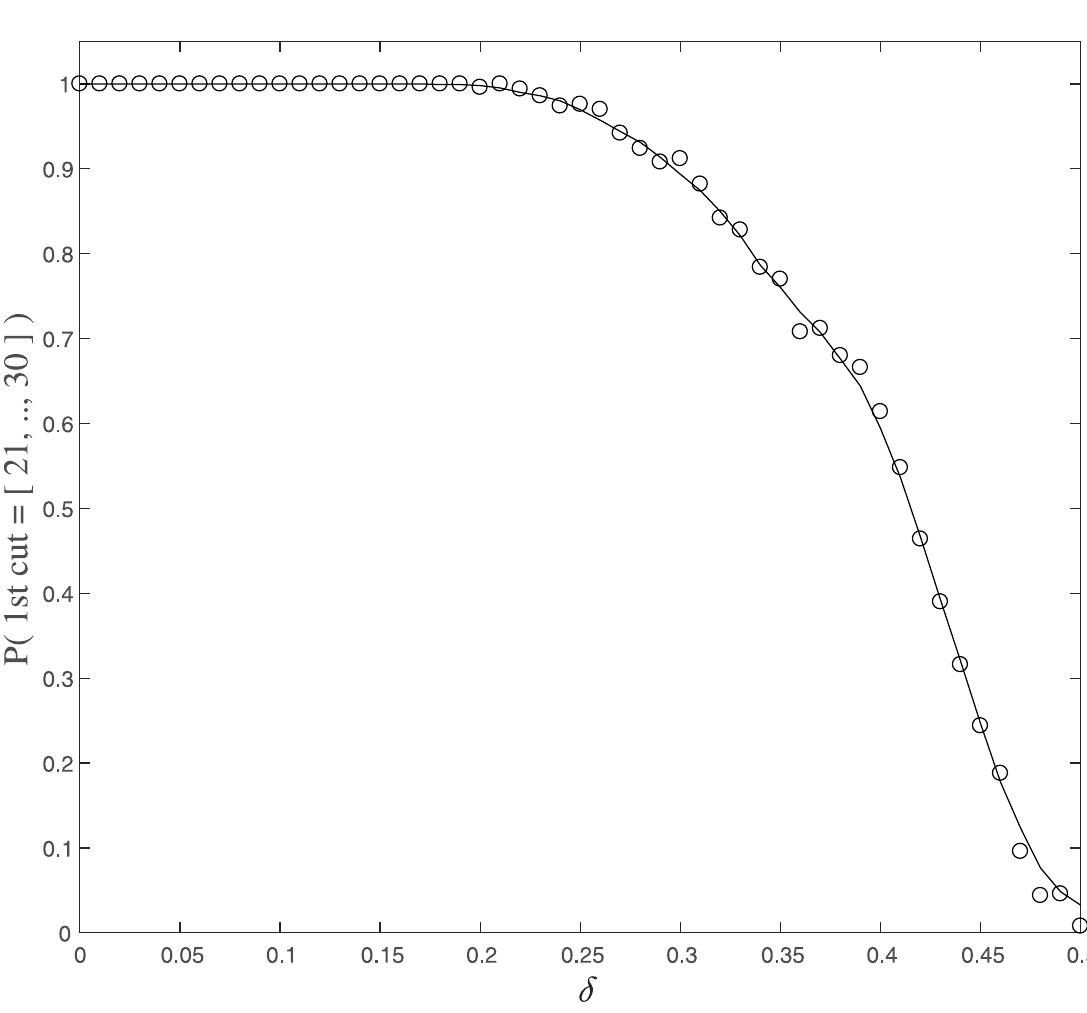
Fig 5. The probability of the subset with the smaller number of elements in the MIP is {21, 22, ... , 30} is plotted as a function of the connection parameter δ 2 [0, 1/2]. Each circle shows the sample probability of 500 independent simulations, and the solid line shows the moving average of the